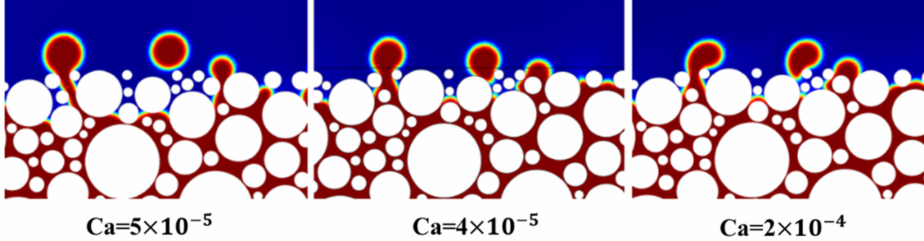
Figure 19. Oil droplets at the same position with different contact angles.